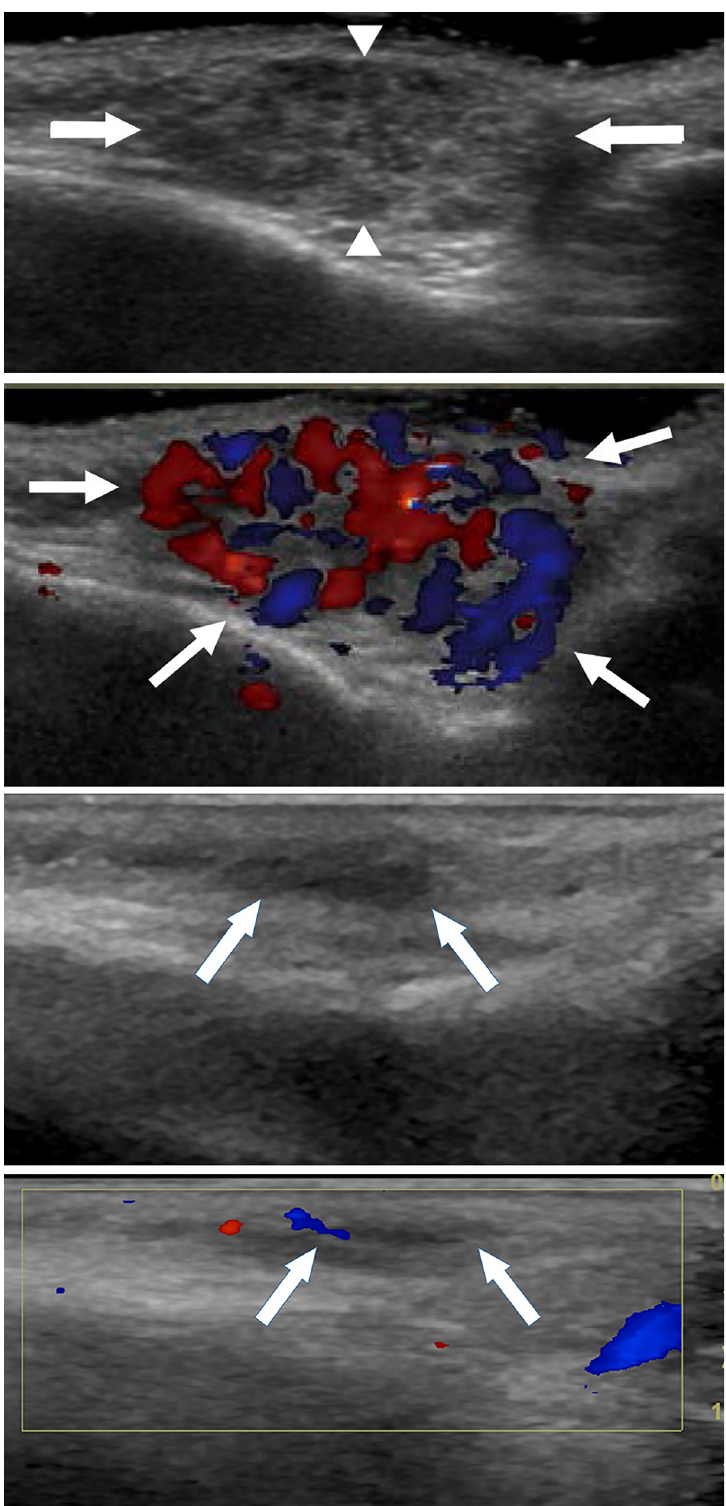
Fig 2. Image of a 4-month-old girl with infantile hemangioma who had near complete regression after 1 year of propranolol treatment. (a) Initial gray-scale US image shows a hypoechoic subcutaneous mass (arrows) without deep tissue involvement. Lesion length was defined as the longest diameter of the tumor (distance between arrows). Lesion